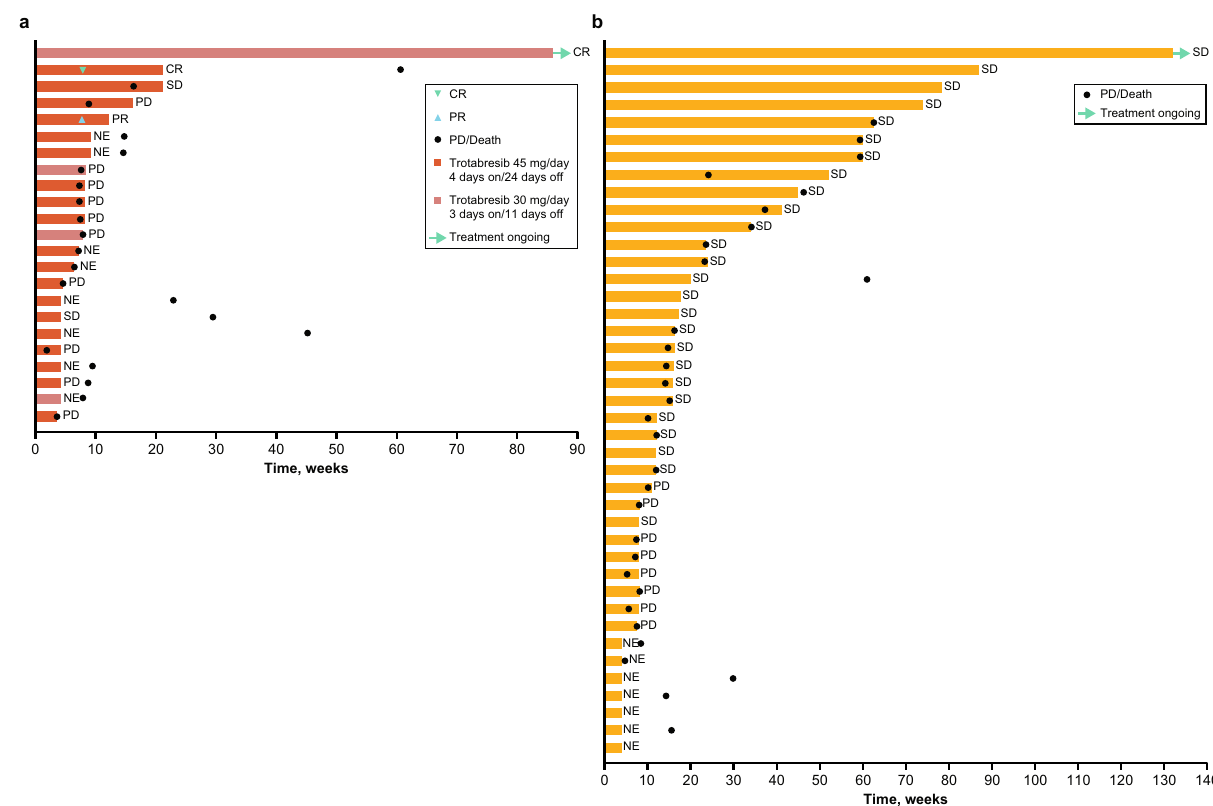
Fig. 4 | Duration of treatment and best response. a Patients with R/R DLBCL in partB( n =23)and b partC ( n =41).Aswimplotshowing the duration of treatment forpatientsinpartAisshowninSupplementaryFig.1.Sourcedataareprovidedasa